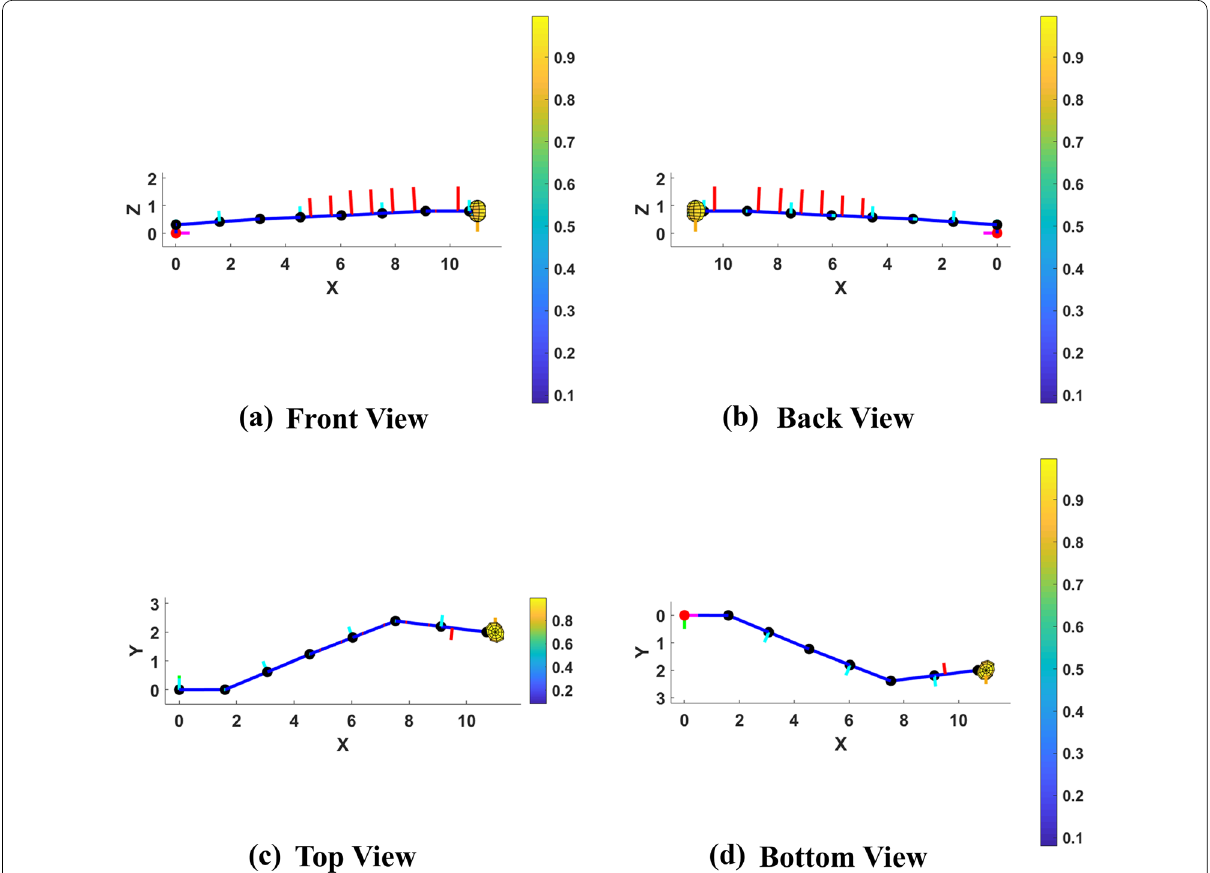
Fig. 5 The front, back, top, and bottom views of the human-experience-based flying watch allocation, end effector reaction force, and the corresponding average TDS in the static object holding mission. a Front view. b Back view. c Top view. d Bottom